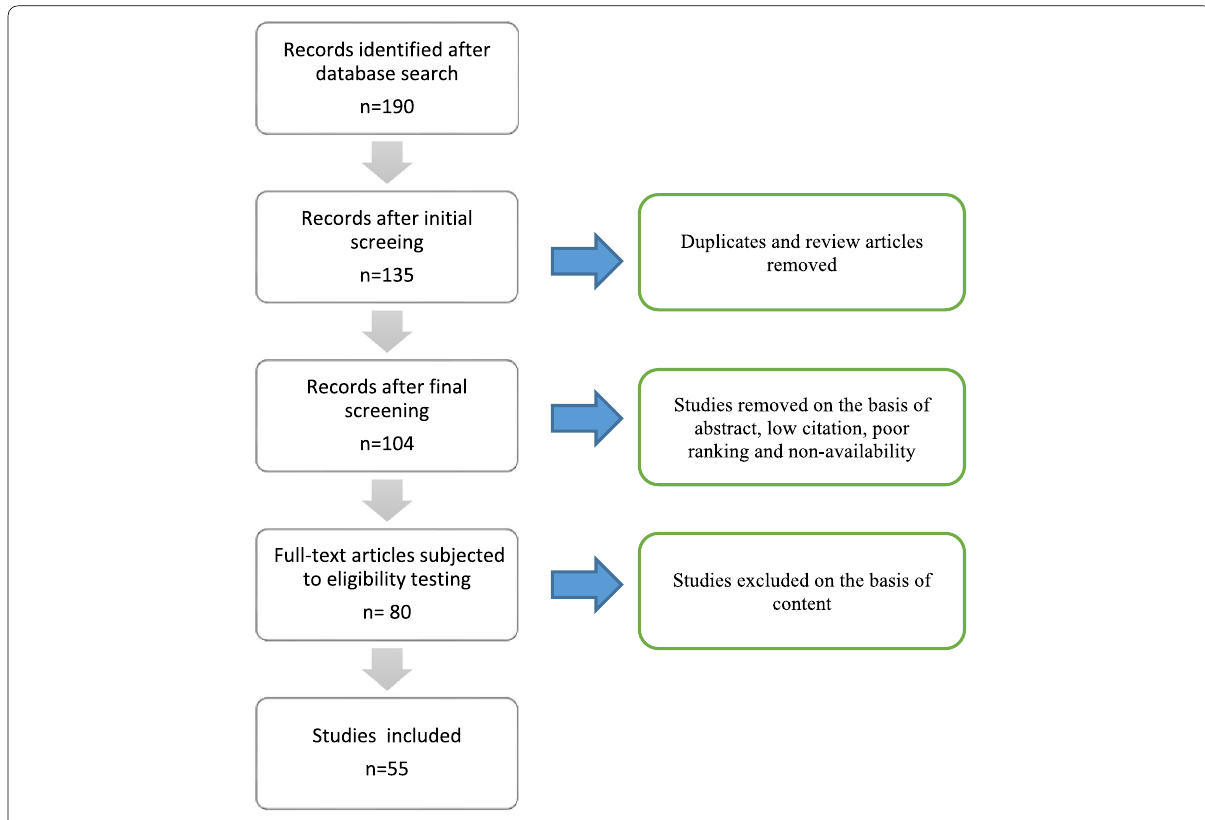
Fig. 1 Flowchart describing the steps of the methodology